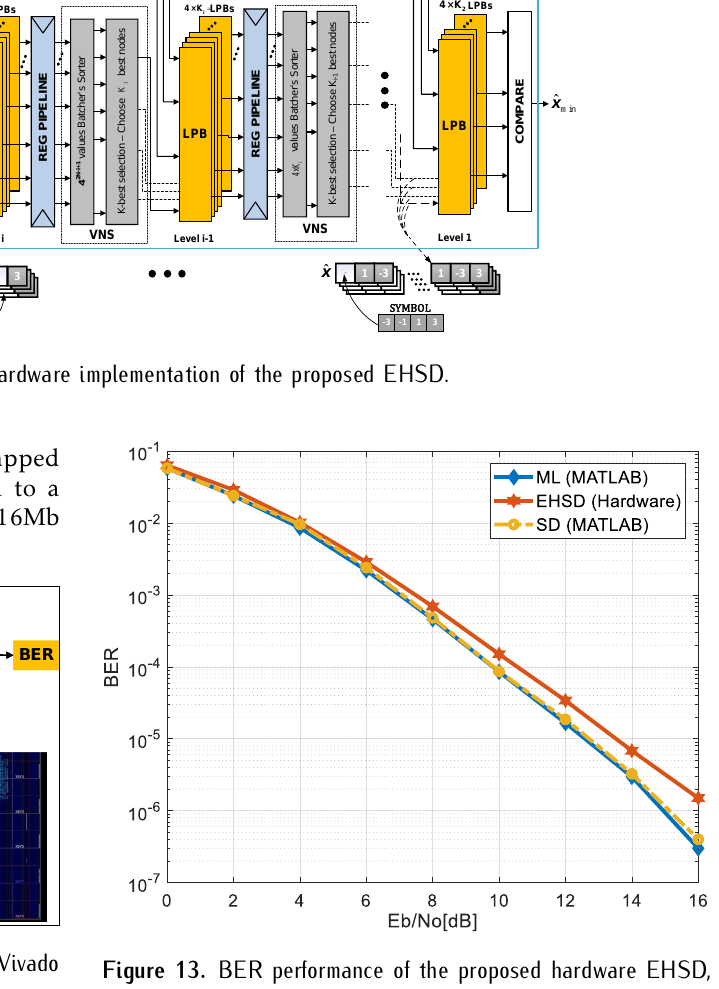
Figure 13. BER performance of the proposed hardware